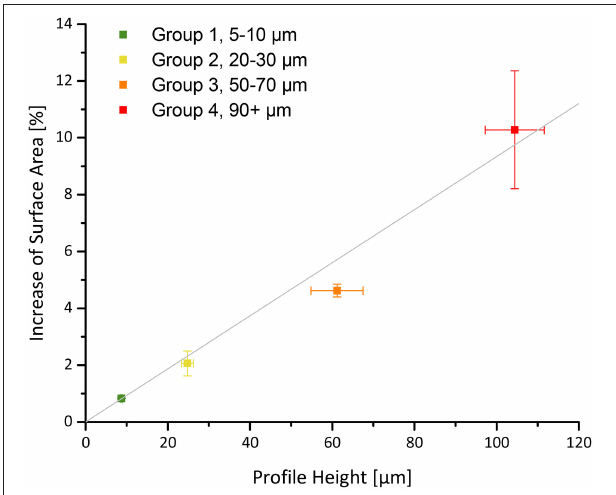
FIGURE 2 | Increase of waviness surface area of micro-structured electrodes compared to a polished electrode (point of